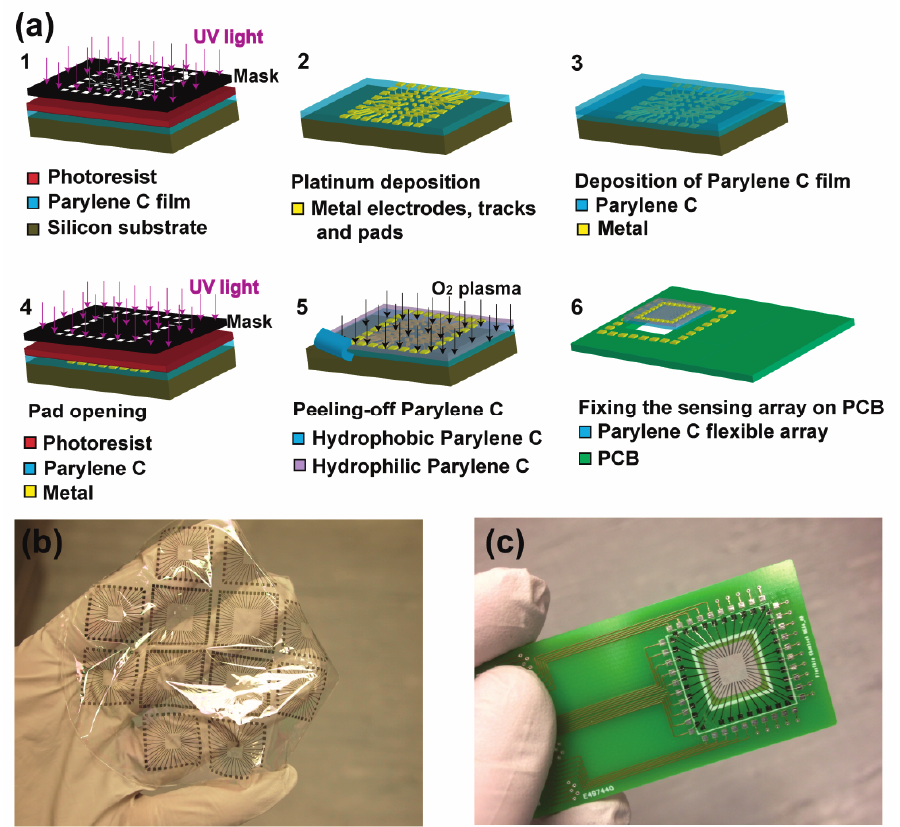
Figure 1. ( a ) Schematic of fabrication process of flexible sensor; ( b ) 5 μ m-thick Parylene C flexible pH sensing arrays; ( c ) PCB-based prototype with the flexible chemical array located in the